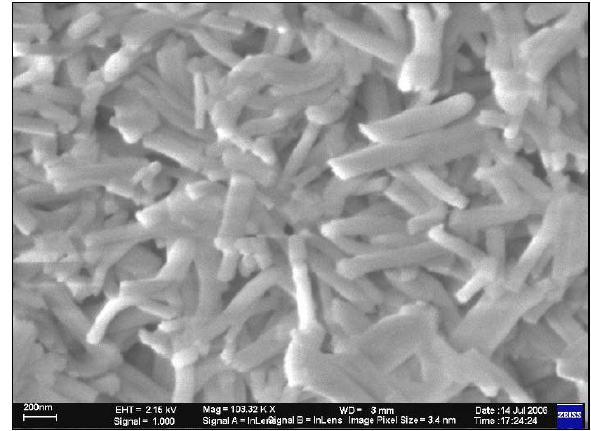
Figure 2. Scanning electron microscopy of the mesoporous silica. The images were obtained at 20 kV, and the material was previ- ously covered with a gold